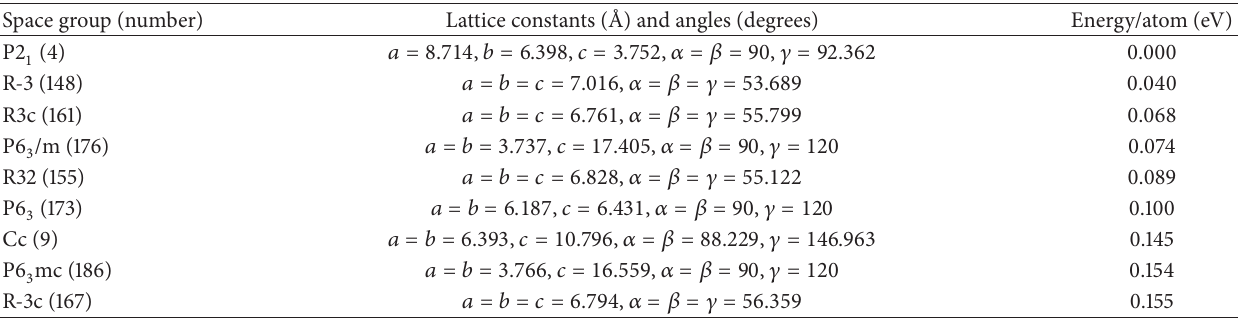
Table 1: The predicted most stable structures of ZnSnS 3 at atmospheric pressure. The space groups that describe the symmetry of the structures, the lattice constants (in ˚A), the angles between the lattice vectors (in degrees), and the relative energies per atom (in eV) are shown. For ease of comparison, the energy per atom of the most stable structure is set equal to